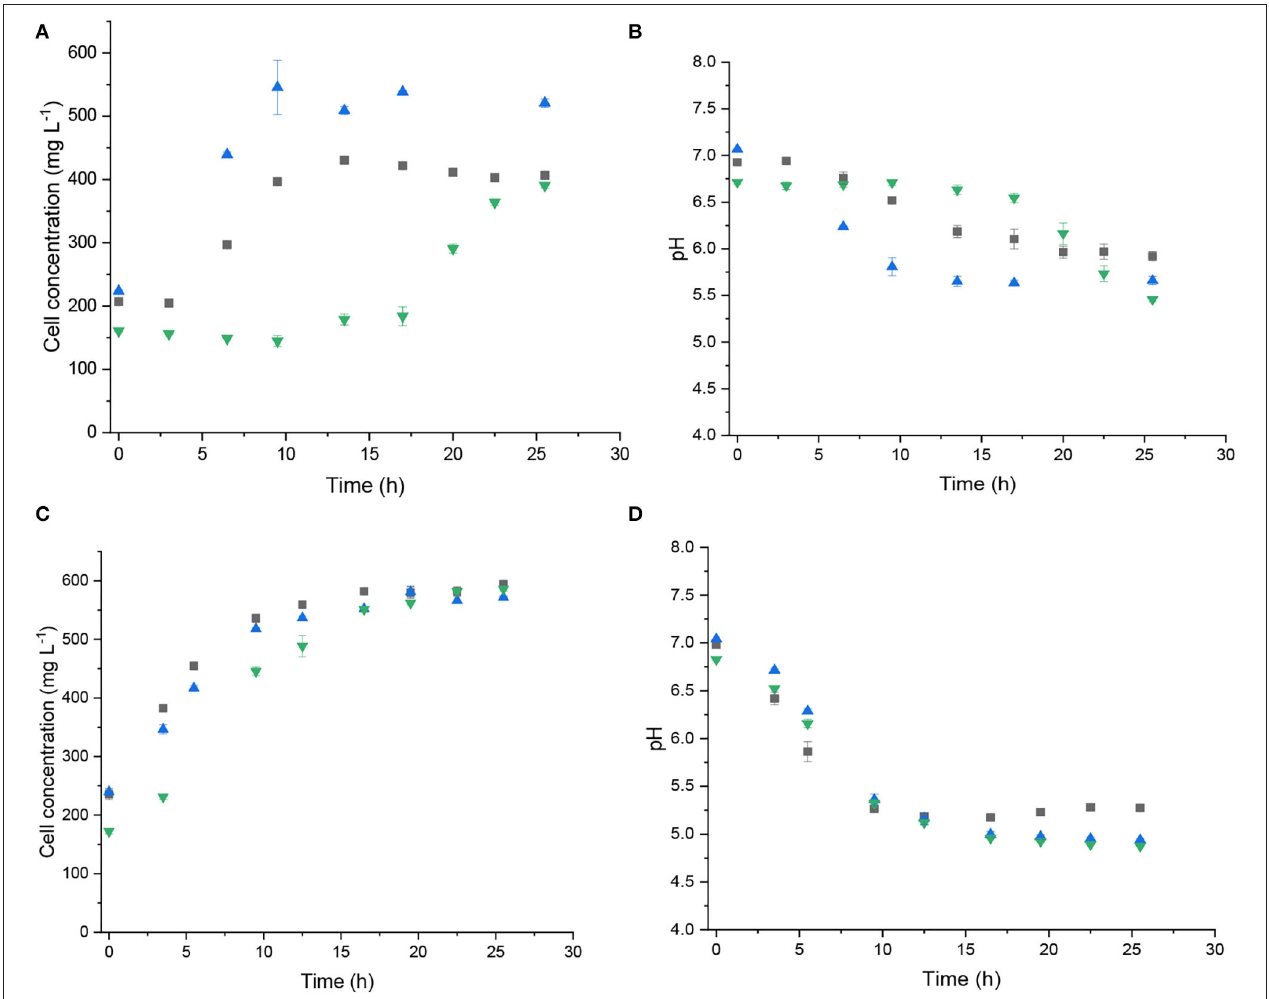
FIGURE 1 | Cell concentration and pH during glycerol batch fermentations with C. beijerinckii Br21 (A,B) or C. pasteurianum DSMZ 525 (C,D) . Glycerol at 80mM ( (cid:4) ), 390mM ( ), and 1,100mM (